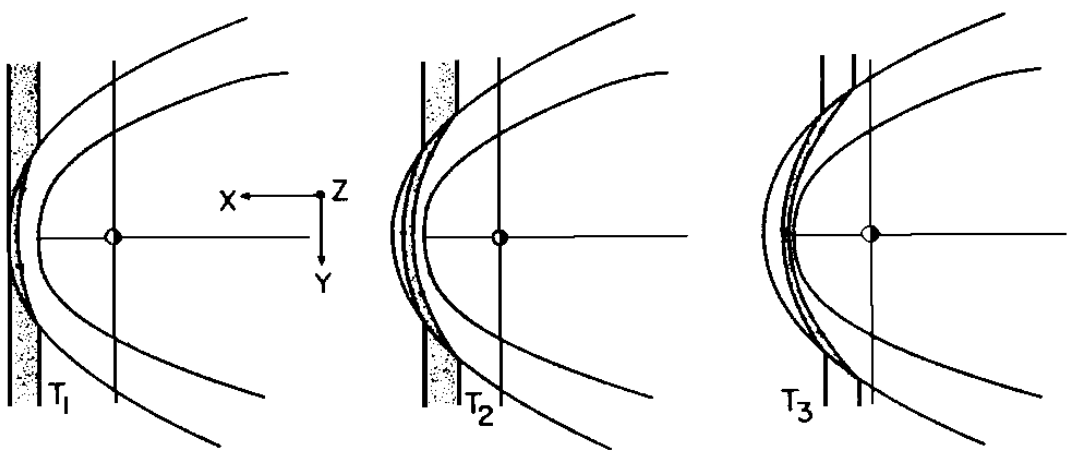
Fig. 1. Taken from Zwan and Wolf (1976). Idealized sketches of the squeezing process at successive times T 1 , T 2 , and T 3 . As plasma moves around the magnetosphere, flux tubes become draped around the nose of the